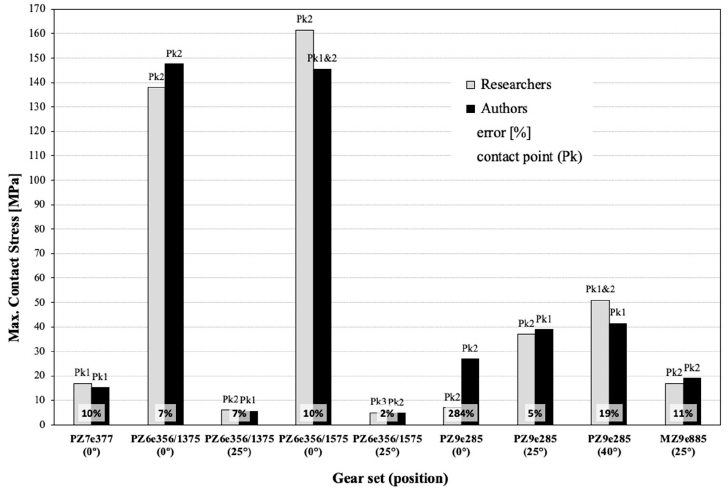
Figure 5. Results comparison Researchers vs. Authors, relative error [%] in maximum contact stress [MPa] and contact point (Pk) of maximum contact stress in each gear set for corresponding angular position in brackets (degree °).